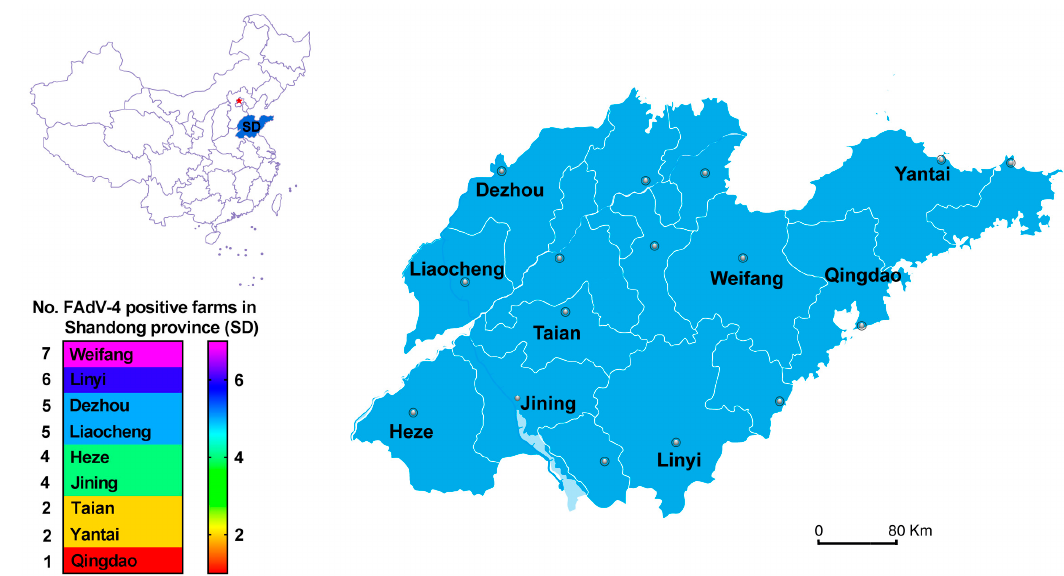
Figure 1. Geographical distribution of farms testing positive for FAdV-4 in Shandong province, China. Key cities within the province are represented by dots, and those cities from which positive samples were collected are named. The number of FAdV-4-positive farms involved in the study from each city were as follows: Dezhou (5), Heze (4), Jining (4), Liaocheng (5), Linyi (6), Qingdao (1), Taian (2), Weifang (7), and Yantai (2).